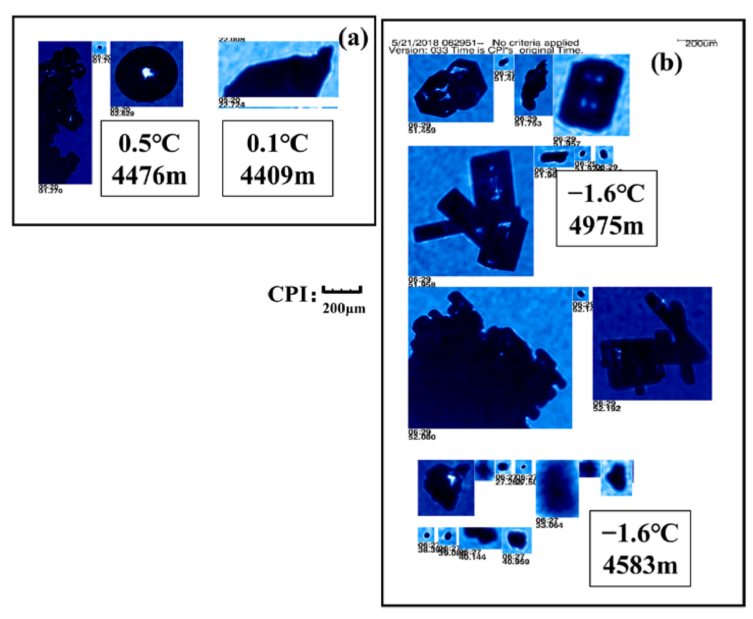
Figure 12. Particles image of the flight on 21 May 2018, ( a ) V1 stage, ( b ) V2 stage. On 24 August 2019, the riming of particles in the negative temperature layer was strong. Large droplets were observed near the 0 ◦ C layer. When the temperature reached 6.5 ◦ C, particles with irregular edges were still observed (Figure